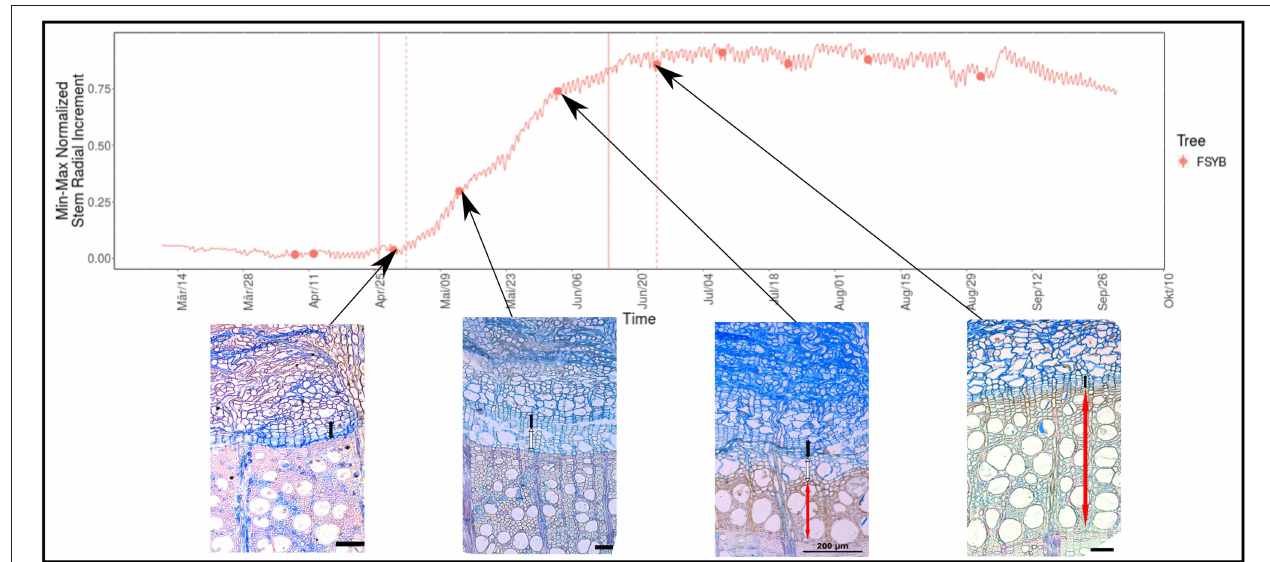
FIGURE 4 | DevX image composition for the beech example. In the top diagram, the normalized (scaled to min-max values) cumulative growth curve for beech specimen “B” in 2016 is shown. The vertical lines depict the growth onset and cessation estimates according to Weibull (solid) and Gompertz (dashed) model fits. Below, the micro-core images relevant to the estimates are shown. Each red dot represents an available micro-core image, which can be displayed by simply clicking on the respective dot. On the lower histological images, the cambium (C) is depicted by a black bar, wood of the current growth ring with cells in the phase of extension and cell wall deposition and lignification (E and W) by a white bar and fully mature (M) cells by a red bar. All Scale bars 100 micrometers (except otherwise stated on the